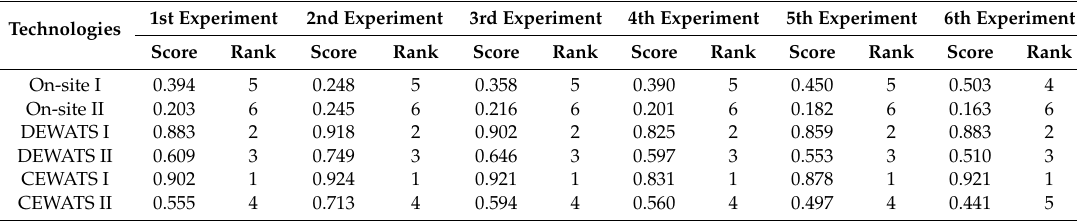
Table 4. The score and ranking of each